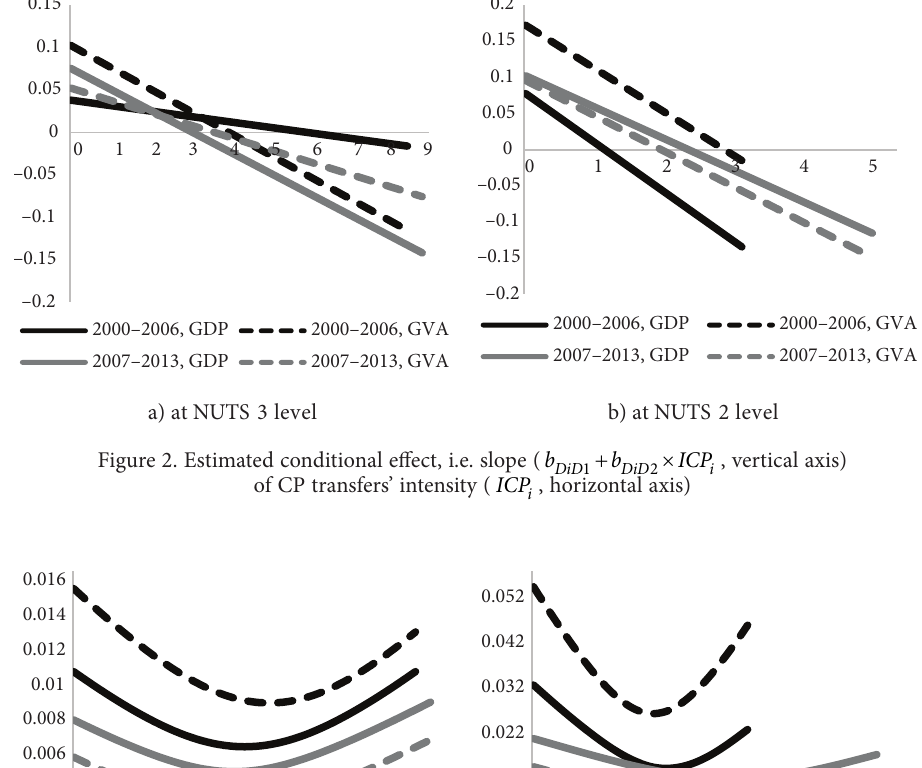
Figure 3. Relationship between CP transfers’ intensity ( i ICP , horizontal axis) and standard error (vertical axis) of estimated conditional effect ( + × 1 2 DiD DiD i b b ICP , vertical axis)